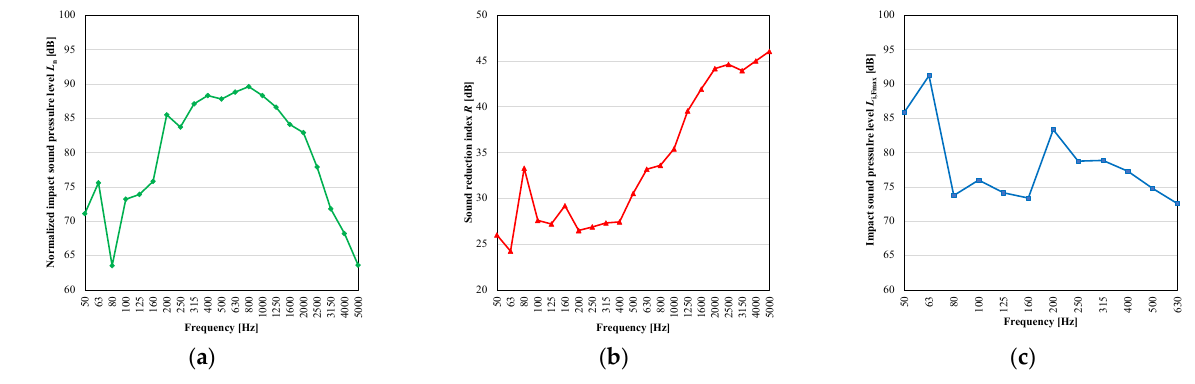
Figure 7. Normalized impact sound pressure level ( a ), sound reduction index ( b ), rubber ball impact sound pressure level ( c ) for the 200 mm CLT floor.